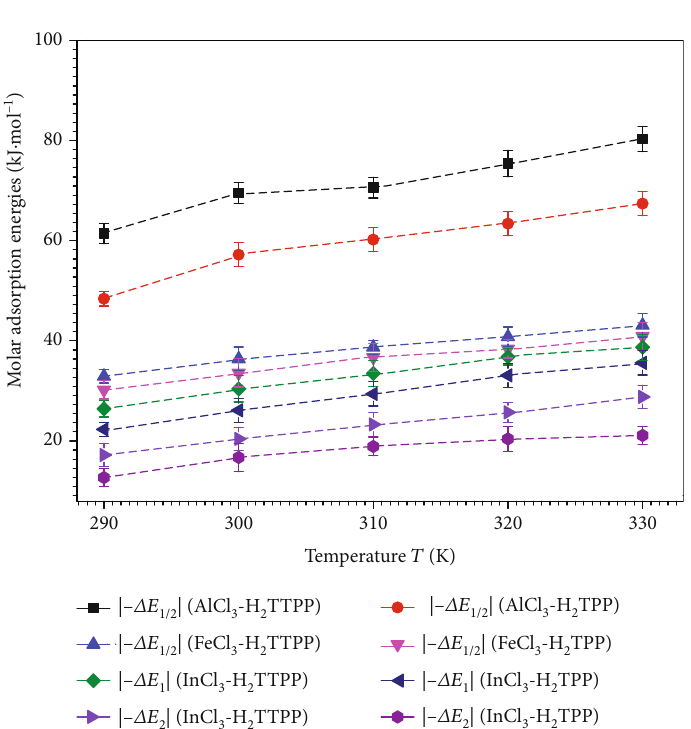
∣ for AlCl and 1/2 3